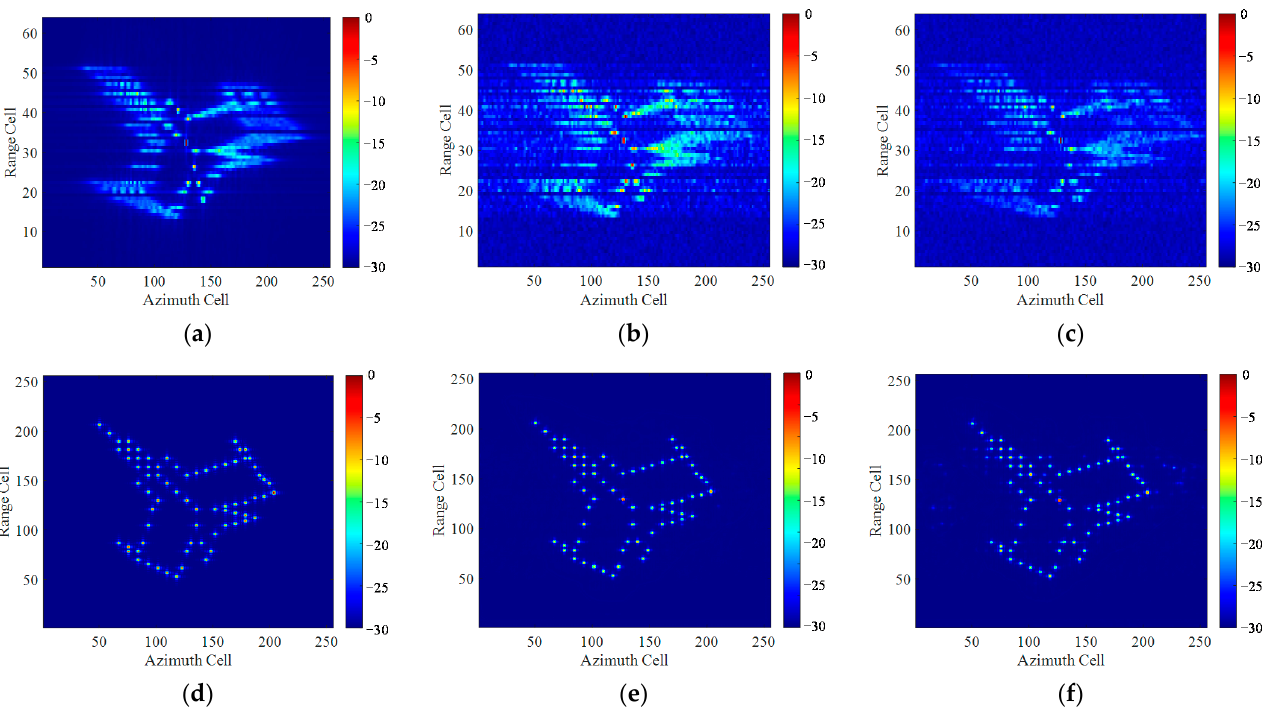
Figure 11. Imaging results of simulated aircraft model with the motion parameters and imaging condition as listed in Table: ( a – c ) Imaging results by RD method; ( d – f ) Imaging results of the proposed method.